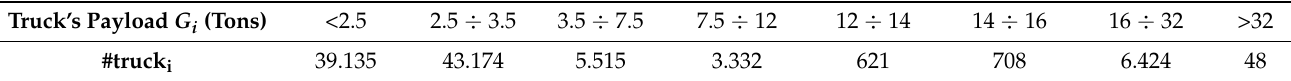
Table 1. Truck fleet in Abruzzo region (2018), grouped for payload range ( i -th). Truck’s Payload G i (Tons)